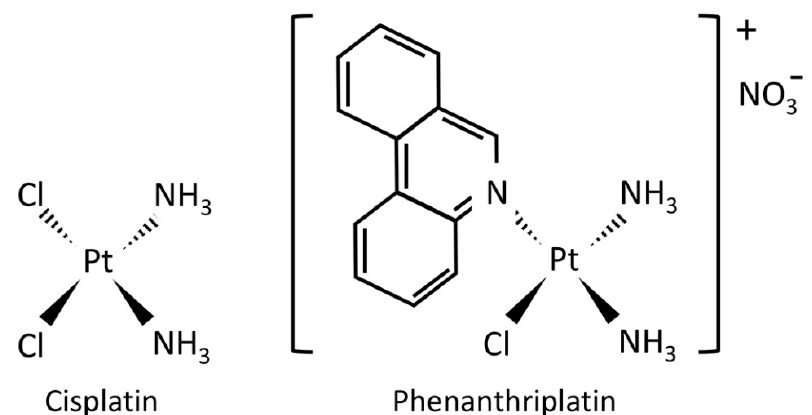
Figure 1. Chemical structures of cisplatin and phenanthriplatin. Cisplatin is a bifunctional platinum(II) complex whose anticancer activity is primarily related to its ability to intercalate and distort DNA leading to activation of DNA repair and cell death mechanisms. Phenanthriplatin is a heterocyclic-ligated monofunctional platinum(II) complex that is proposed to cause cancer cell death via blockage of gene transcription while evading DNA repair mechanisms.